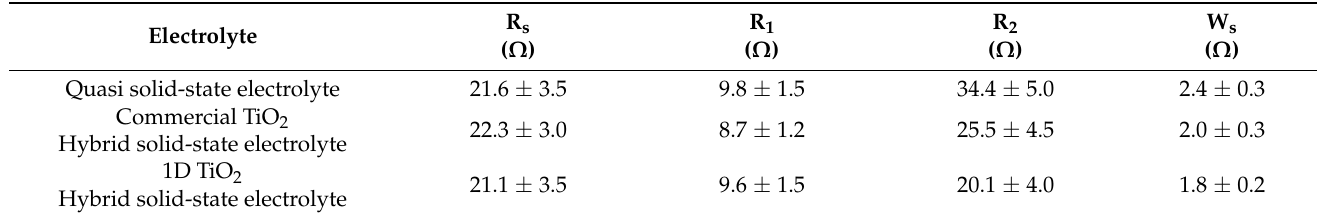
(b). Figure S2: ( a ) N 2 adsorption (filled symbols) and desorption (unfilled symbols) isotherms of mesoporous carbon electrocatalyst derived from PVDC- g -POEM double comb copolymer and ( b ) SEM of mesoporous carbon electrocatalyst. Figure S3: Photovoltaic parameters of mesoporous carbon-based DSSCs fabricated with quasi solid-state electrolyte, commercial TiO 2 hybrid solid-state electrolyte and 1D TiO 2 hybrid solid-state electrolyte at 100 mW/cm 2 . Error bars represent the standard deviation of at least 5 cells. Table S1: Photovoltaic parameters of mesoporous carbon-based dye-sensitized solar cells (DSSCs) with quasi solid-state electrolyte, commercial TiO 2 hybrid solid- state electrolyte, and 1D TiO 2 hybrid solid-state electrolyte at 100 mW/cm 2 (AM 1.5). Table S2: Comparison of photovoltaic parameters of Pt-free counterelectrode based DSSCs fabricated with solid-state electrolytes reported in the